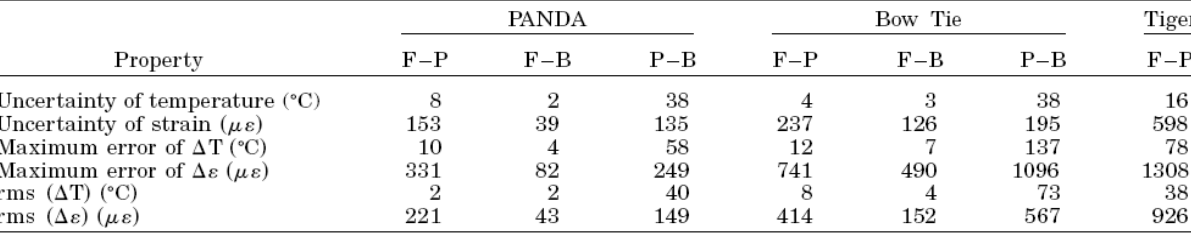
Table 1. Uncertainty of temperature and strain calculated with measured Brillouin frequency (F), power (P), and bandwidth (B) from [60] (Copyright © 2004 OSA, Reprinted with